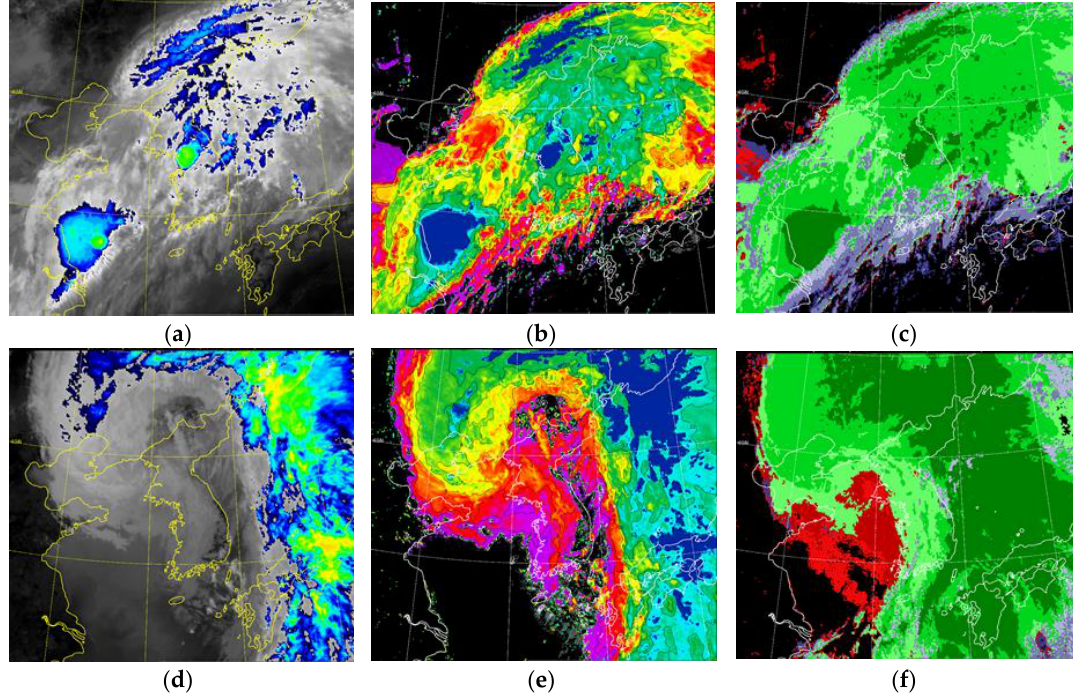
Figure 3. ( a ) Rainfall Intensity (RI), ( b ) Cloud Top Height (CTH), and ( c ) Cloud Type (CT) during convective rain occurring at 23:15 LST, on 5 July 2016. and ( d ) RI, ( e ) CTH, and ( f ) CT during stratiform rain occurring at 15:30 LST, on 3 May 2016 (provided by the National Meteorological Satellite Center).